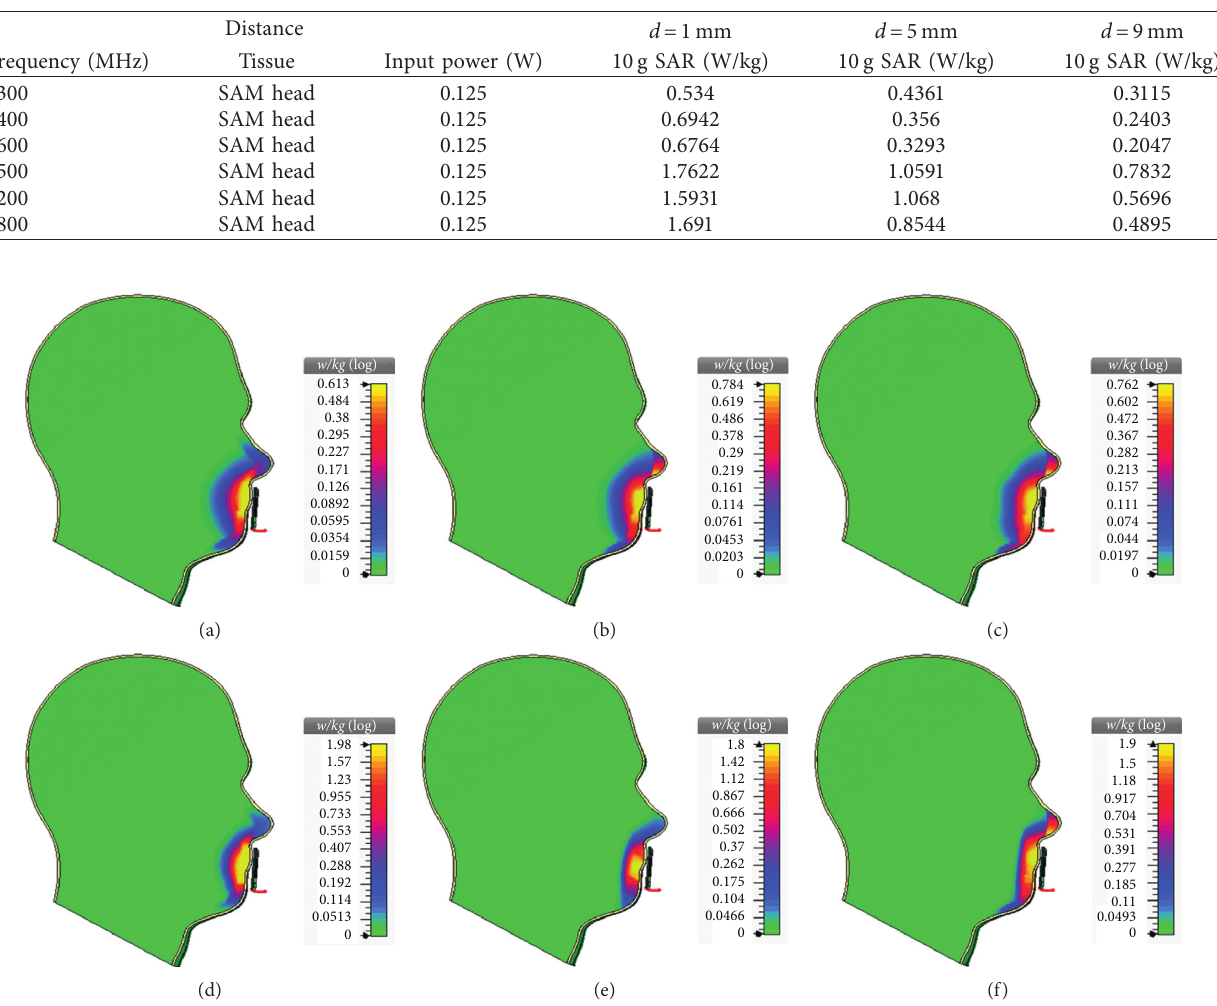
Figure 18: SAR (W/kg) distribution averaged over 10 g inside SAM head, antenna 5mm separated to SAM mouth. (a) 2.3 GHz. (b) 2.4 GHz. (c) 2.6 GHz. (d) 3.5 GHz. (e) 5.2 GHz. (f) 5.8